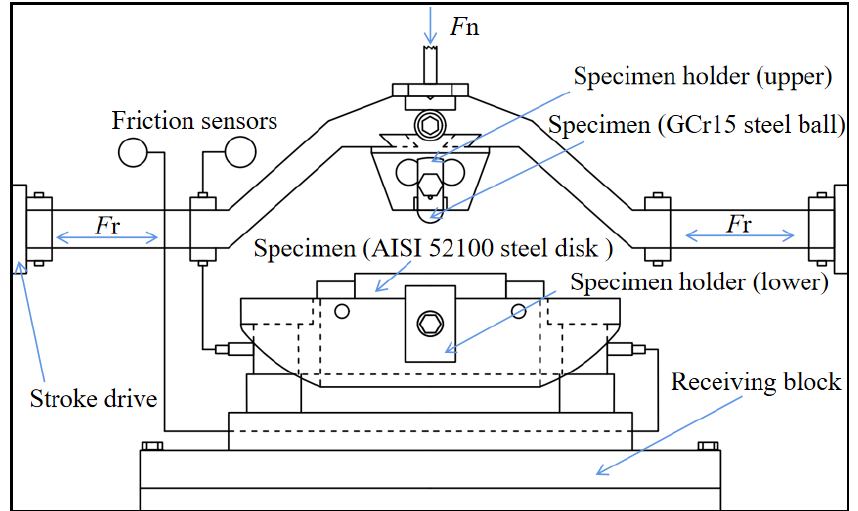
Figure 3. Schematic diagram of fretting wear tester.